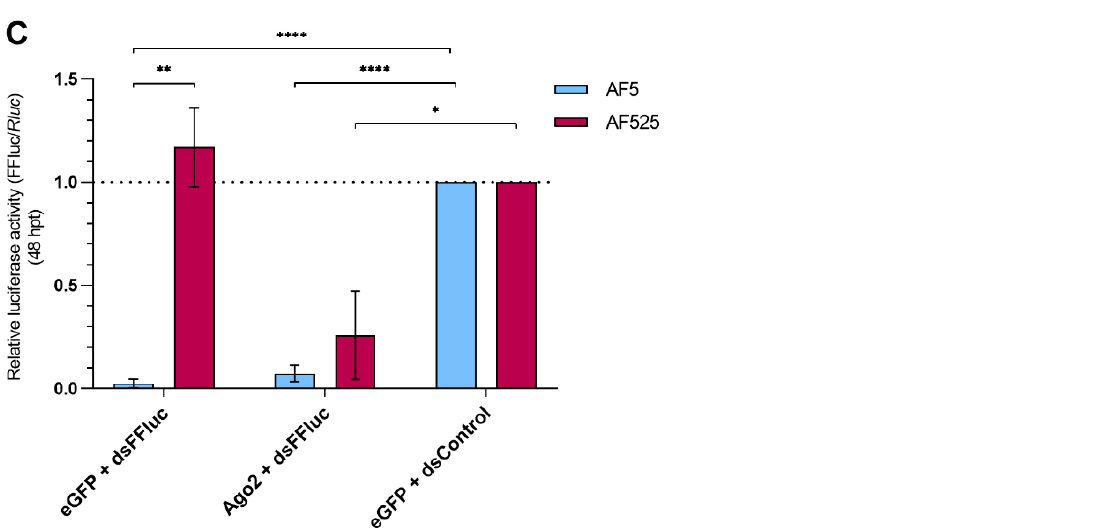
Figure 1. Characterization of AF525-Ago2 knockout cells by luciferase assay. Control cells AF5 and Ago2 knockout cells AF525 were co-transfected with FFluc and Rluc (internal transfection control) luciferase reporter plasmids together with either dsRNA ( A ) or siRNA ( B ) targeting FFluc or corresponding controls (dsRNA eGFP- or siRNA hygromycin B-specific; dsControl or siControl, respectively). ( C ) The experiment in panel A was repeated, but additionally, either Ago2 or eGFP (control) expression constructs were co-transfected and dsRNA against lacZ (control) was used as a control. At 48 hpt, relative luciferase activity (FFluc/ Rluc ) was determined and normalized to control cells. Means with SEM are shown for three independent experiments performed in triplicate (**** represents p ≤ 0.0001, ** represents p ≤ 0.01, * represents p ≤ 0.05, Student t -test).